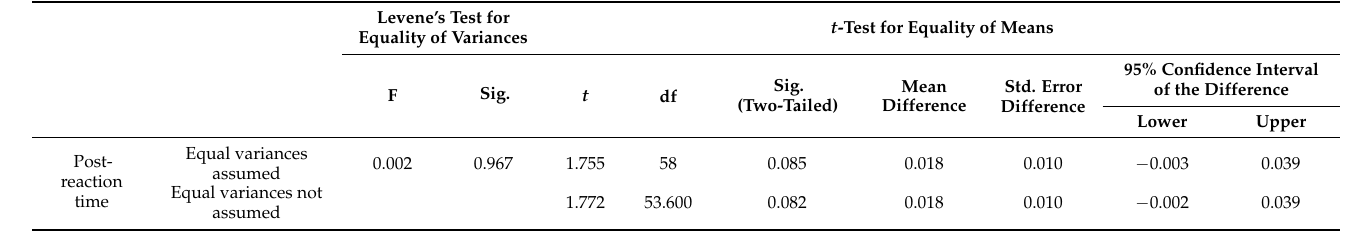
Table 4. Independent samples t -test (computer science students and sports science students).